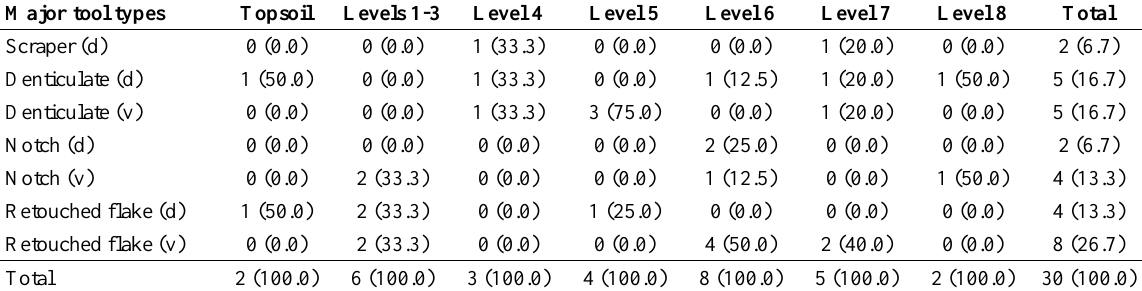
Table 5. Retouched tools from Square 2 of Tell Ghanem al-Ali. Abbreviations: d: retouched on dorsal surface; v: retouched on ventral